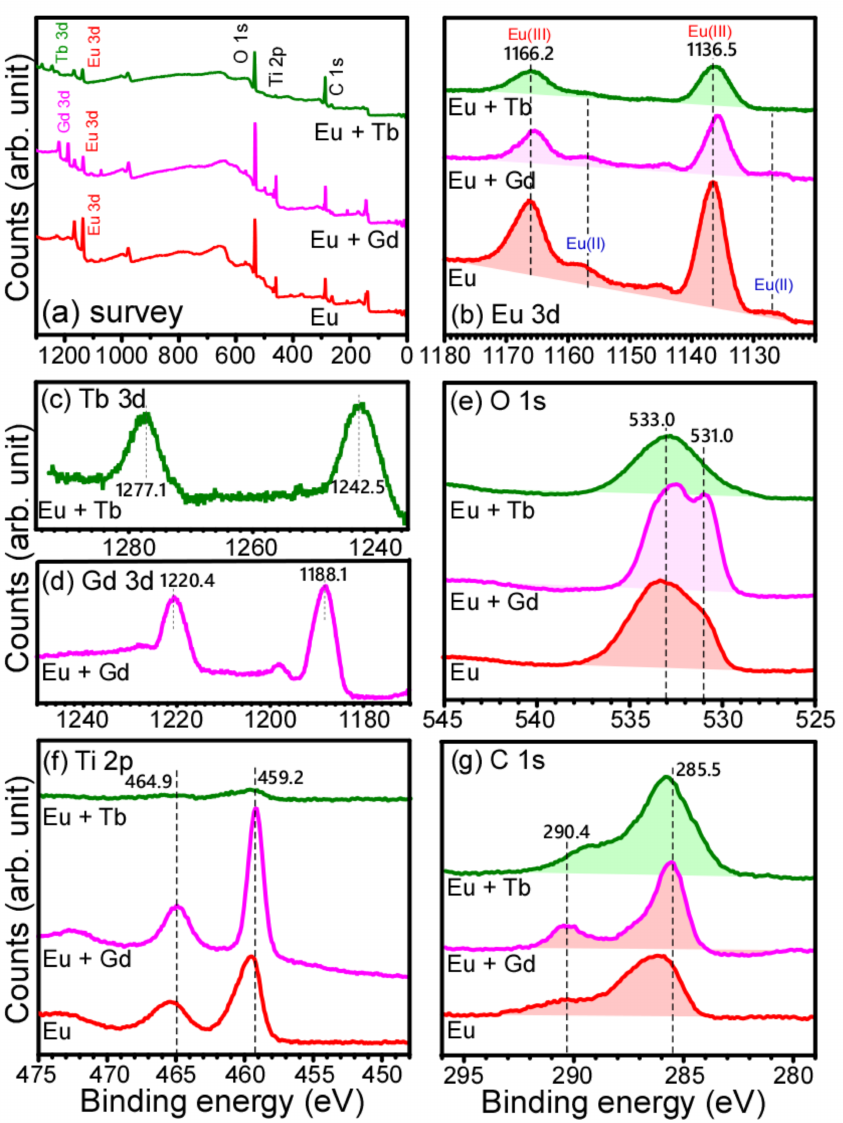
Figure 6. Survey ( a ), Eu 3d ( b ), Tb 3d ( c ), Gd 3d ( d ), O 1s ( e ), Ti 2p ( f ), and C 1s ( g ) XPS spectra for electrodeposited Eu (red line), Eu + Gd (pink line) and Eu + Tb (green line) on TiNS-SiTpy